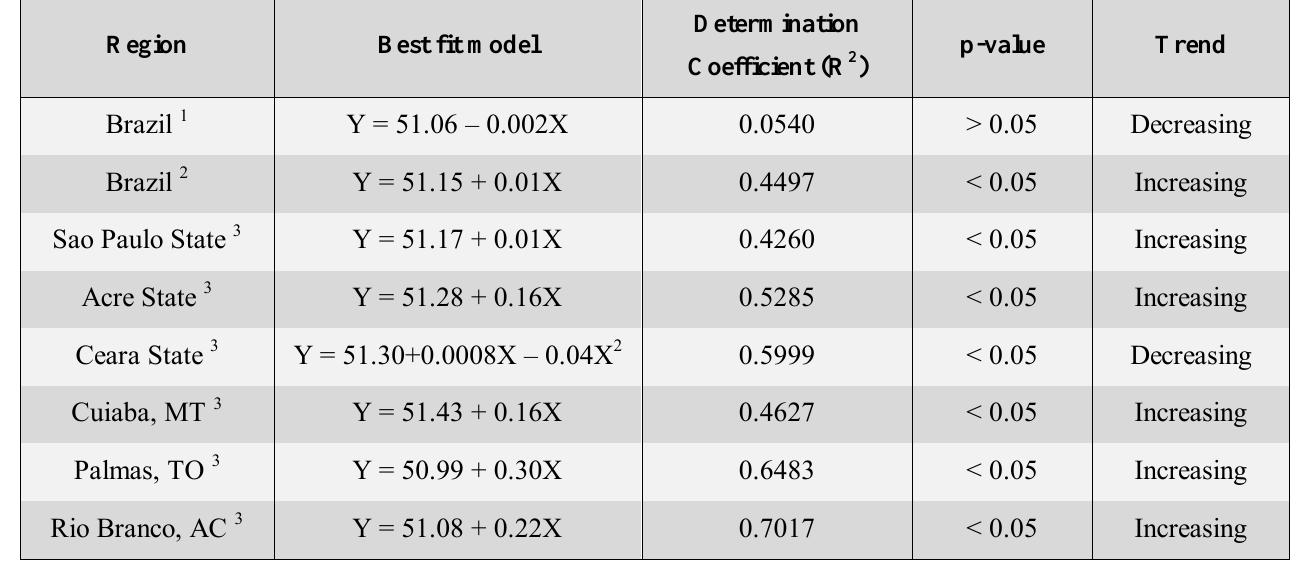
Table 1. Male proportion at birth, Brazil, selected states and capitals,